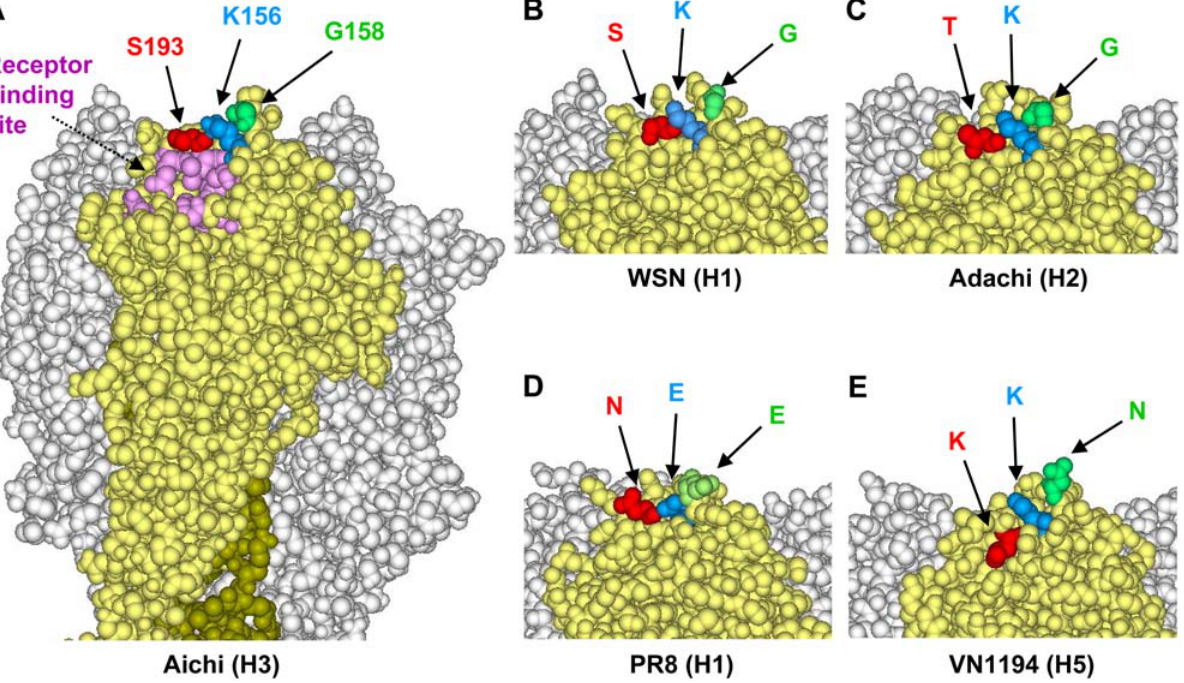
Figure 5. Structure of the MAb S139/1 epitope on the globular head of HA trimer models. Three-dimensional models of Aichi (H3) (A), PR8 (H1) (D), and VN1194 (H5) (E) HAs were constructed from the coordinates obtained from the Protein Data Bank (PDB codes: 1HGF, 1RVX, and 2IBX, respectively). The structures of WSN (H1) (B) and Adachi (H2) (C) were constructed by homology modeling as described in Materials and Methods. Images were prepared by using DS Visualizer (version 1.7, Accelrys, Inc.). Residue numbering is thoroughly on the basis of the H3 HA